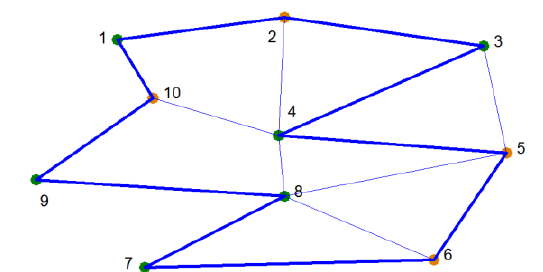
Figure 2. Network topology for N = 10 nodes (red nodes are informed).